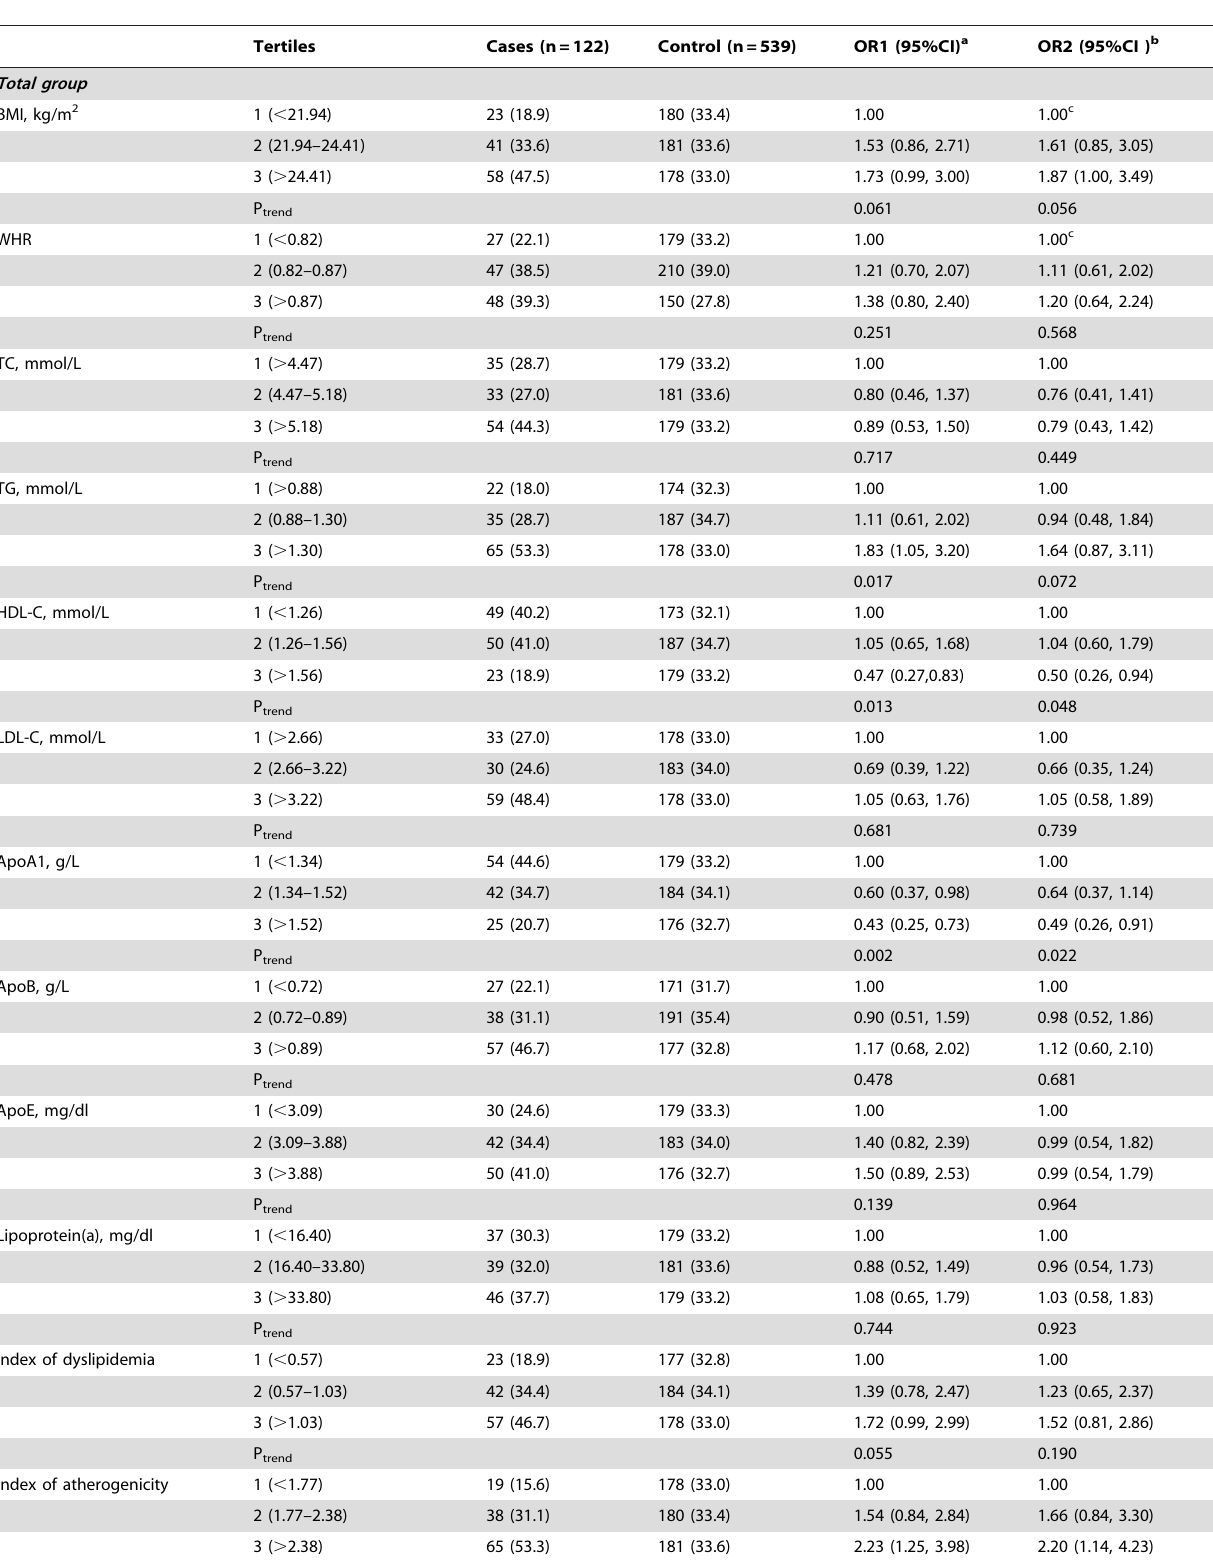
Table 3. Characteristics of hysterectomy-confirmed cases with uterine fibroids and controls and odds ratios of uterine fibroids according to subclinical atherogenic and cardiovascular risk